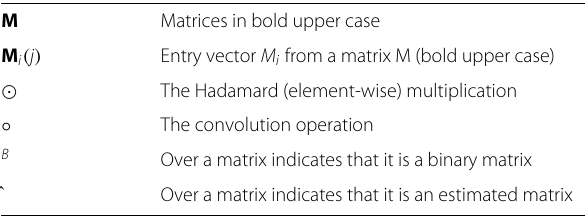
Table 1 Nomenclature, symbols, and